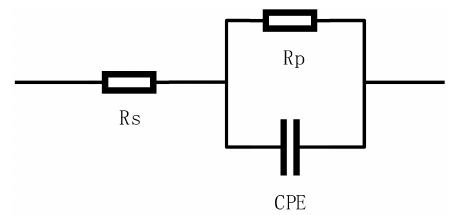
Figure 7. EIS fitting circuit